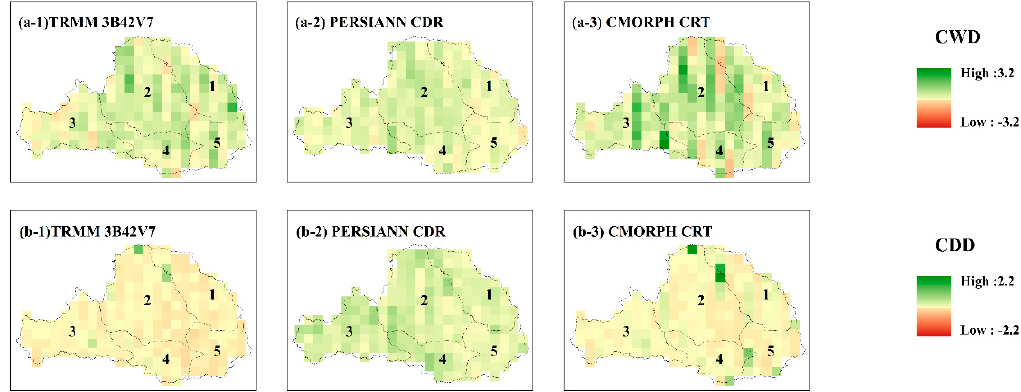
Figure A2. The spatial distribution of mean relative error of consecutive wet days (CWD) and consecutive wet days (CDD) for the three post real-time products.